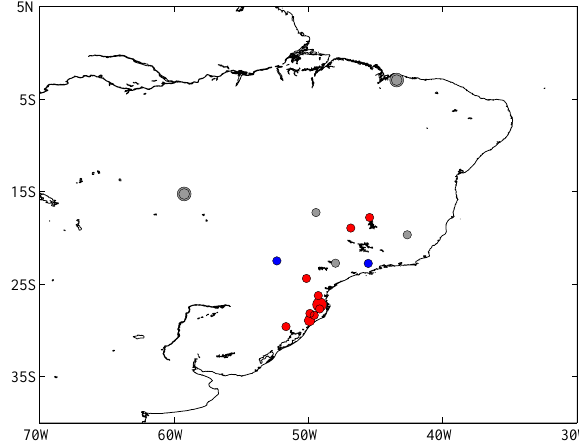
Fig. 6. MH salinity palaeodata off eastern South America. Symbol colours: blue circle, fresher than present; and red circles, saltier than present. Symbol size refers to palaeodata Q -index (a chronological reliability index; see text for more information) values; larger sym- bols indicate higher Q -index values. Vertical axis refers to latitude values, and horizontal axis refers to longitude values.